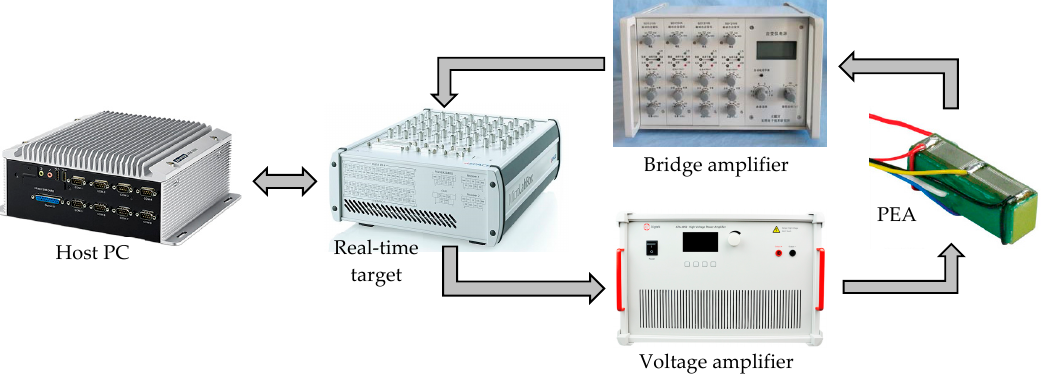
Figure 1. Schematic of the system setup for the standalone piezoelectric actuator (PEA).